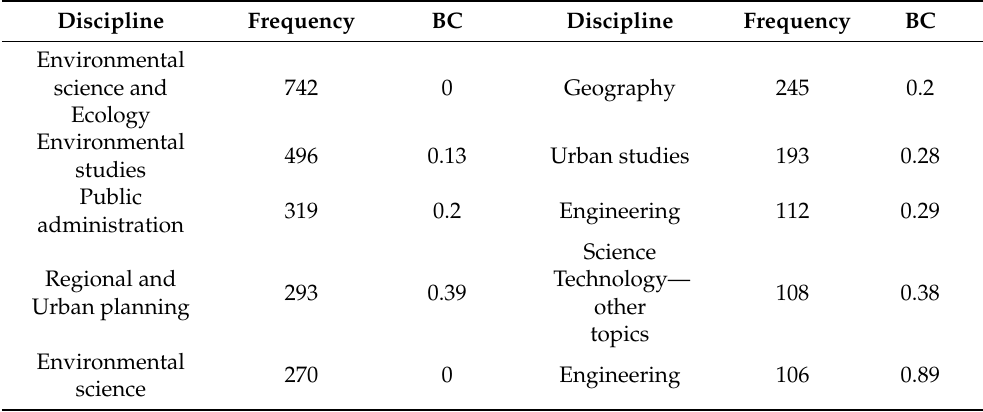
Figure 6. Visualization of the discipline categories (WOSCC). Table 3. Top ten disciplines in the research field of spatial planning